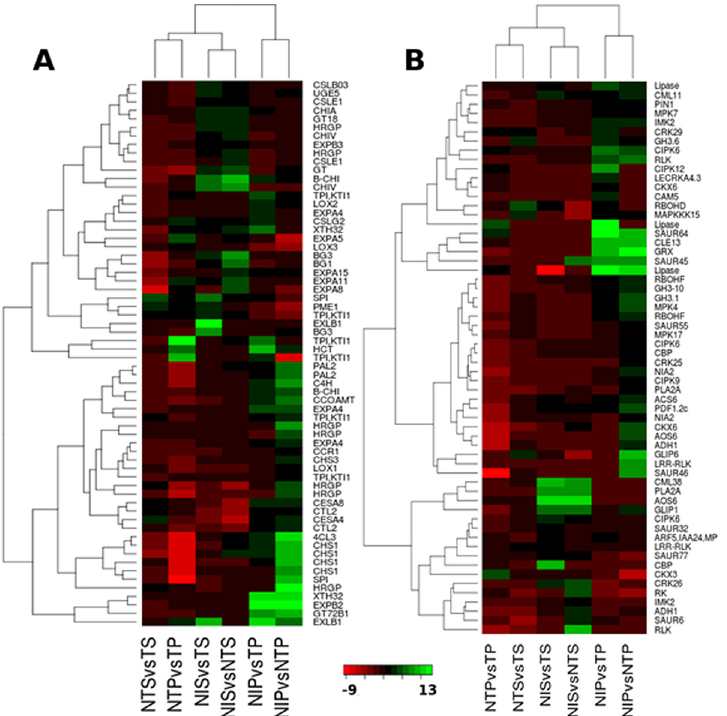
color represents down-regulated (log2FC (cid:3) 2) genes. For description of the gene names represented in the heatmaps please refer to the S1 Table, sheet